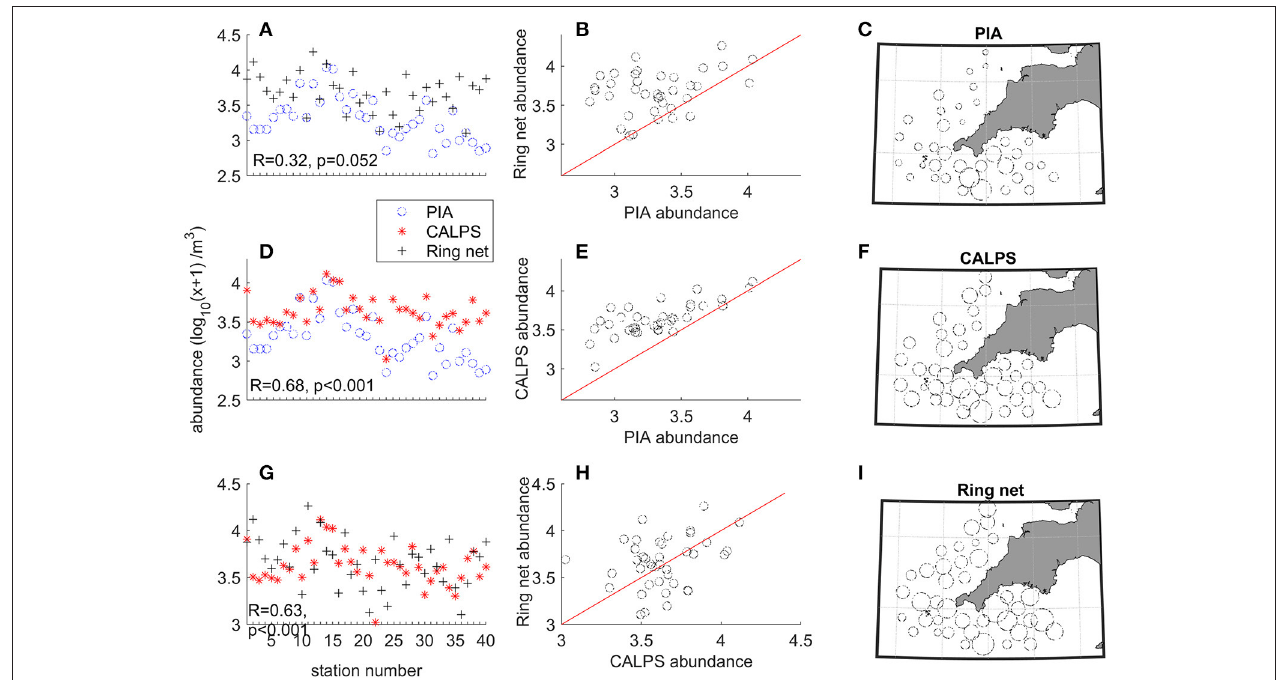
FIGURE 4 | Comparison of the total zooplankton abundances recorded by the PIA, CALPS, and ring net sampling devices. Column 1: Total zooplankton abundance [individuals m − 3 , with log 10 (x + 1) transformation] at all stations for (A) PIA and ring net; (D) PIA and CALPS; and (G) CALPS and ring net. Column 2: Total zooplankton abundance for one gear vs. another one, with red line representing Gear 1 = Gear 2. (B) ring net vs. PIA, (E) CALPS vs. PIA, and (H) ring net vs. CALPS. Column 3: distribution of total zooplankton collected with (C) PIA, (F) CALPS, and (I) ring net, at all stations plotted using the same